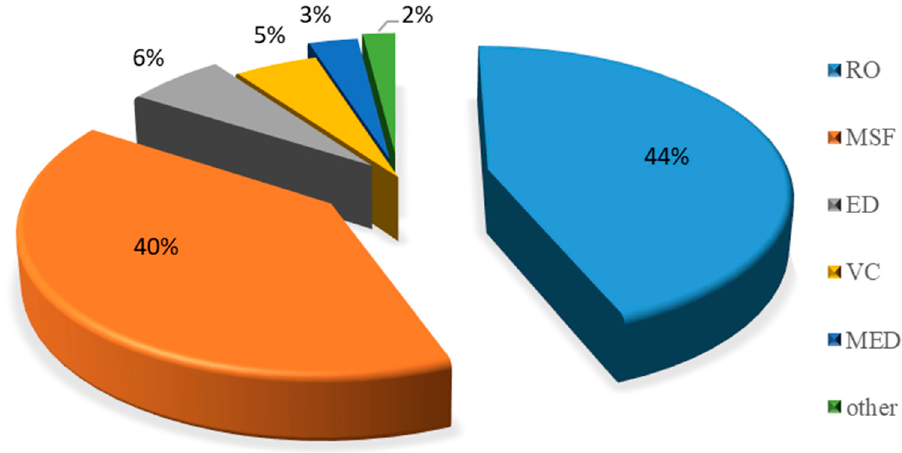
Figure 2. The distribution of desalination capacity for different processes (adapted from Greenlee et al. 2009) [5]